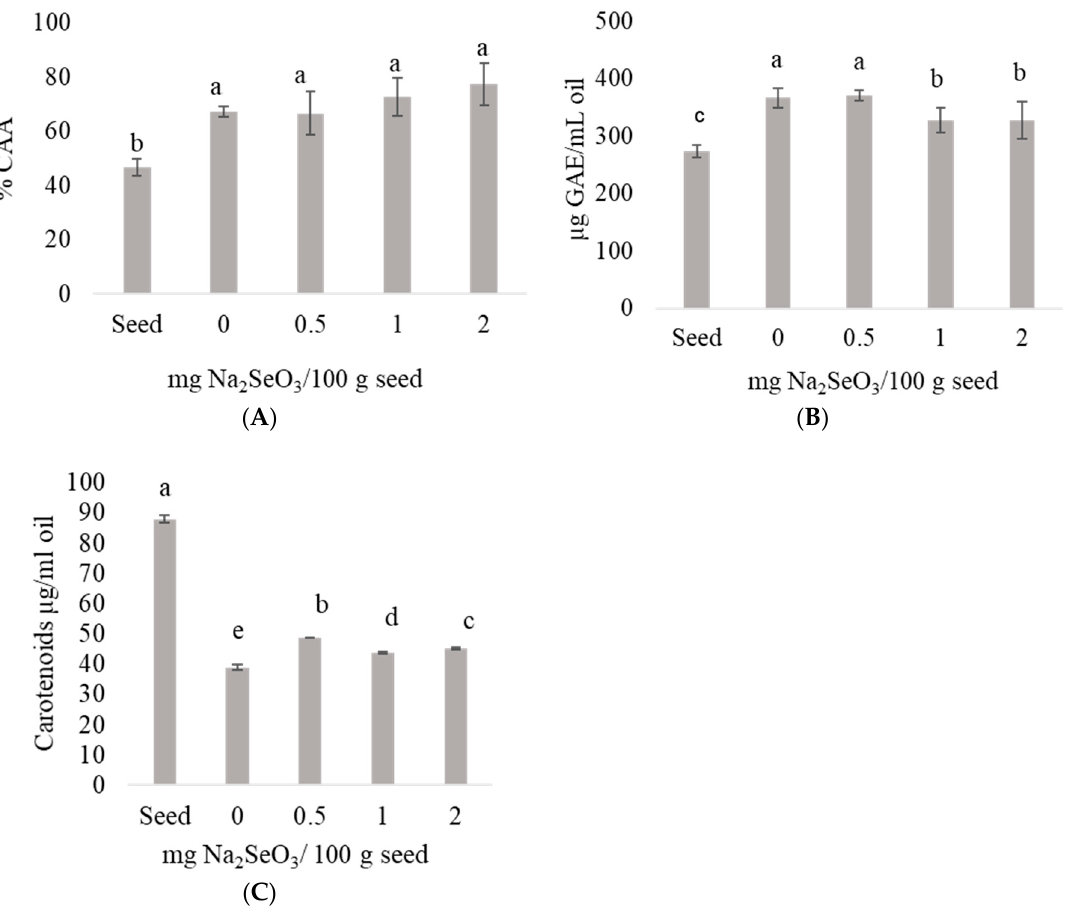
Figure 2. Effect of sodium selenite on cellular antioxidant activity (CAA) ( A ), total phenolic compounds ( B ) and total carotenoids ( C ) measured in chickpea oils obtained from sprouts germinated for four days. Values depicted are averages and bars represent standard deviations. GAE = Gallic acid equivalents. Different letters above bars indicate statistical differences ( p < 0.05).